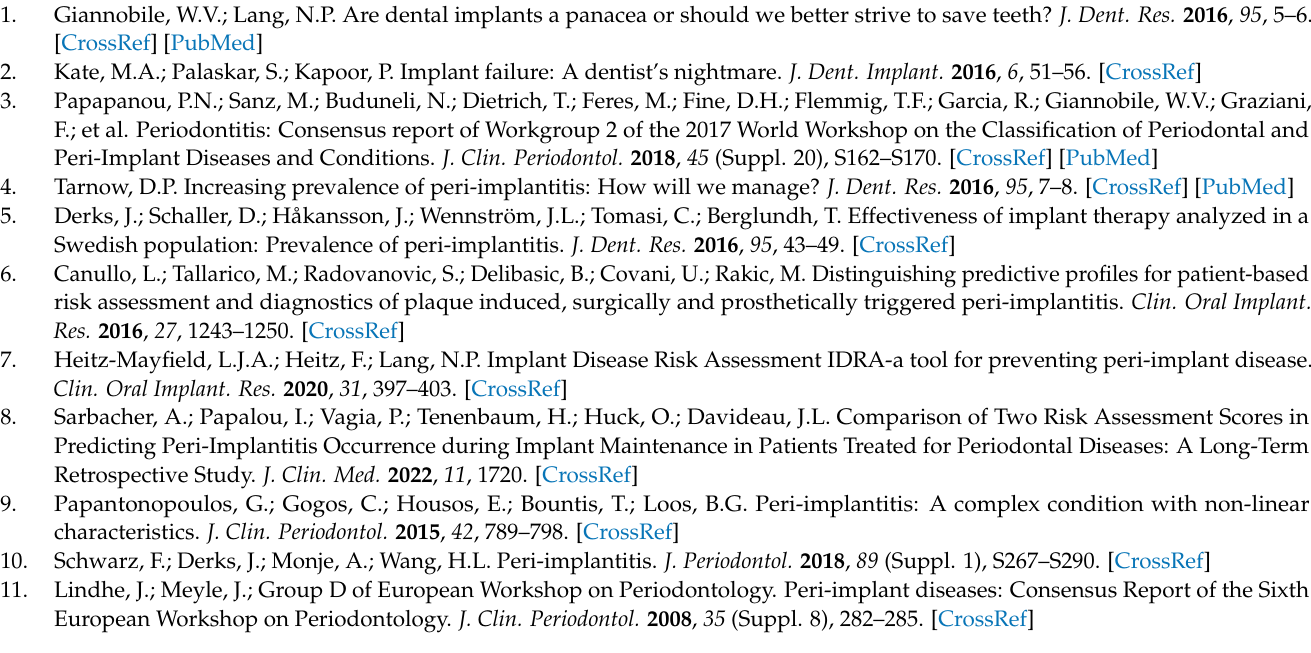
; Table S2: 【 Patient level 】 Fisher's exact test （ Treatment outcome × Grade ） ; Table S3: 【 Implant level 】 Fisher's exact test （ Treatment outcome × Stage ） ; Table S4: 【 Implant level 】 Fisher's exact test （ Treatment outcome × Grade ）